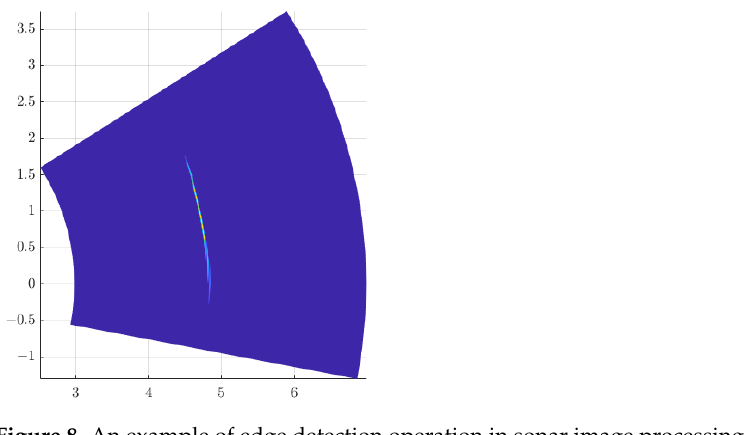
Figure 8. An example of edge detection operation in sonar image processing. The measurement was performed in a pool in which a cube-shaped object was placed. The side wall of the cube was directed perpendicular to the axis of the beam generated by the sonar. [own